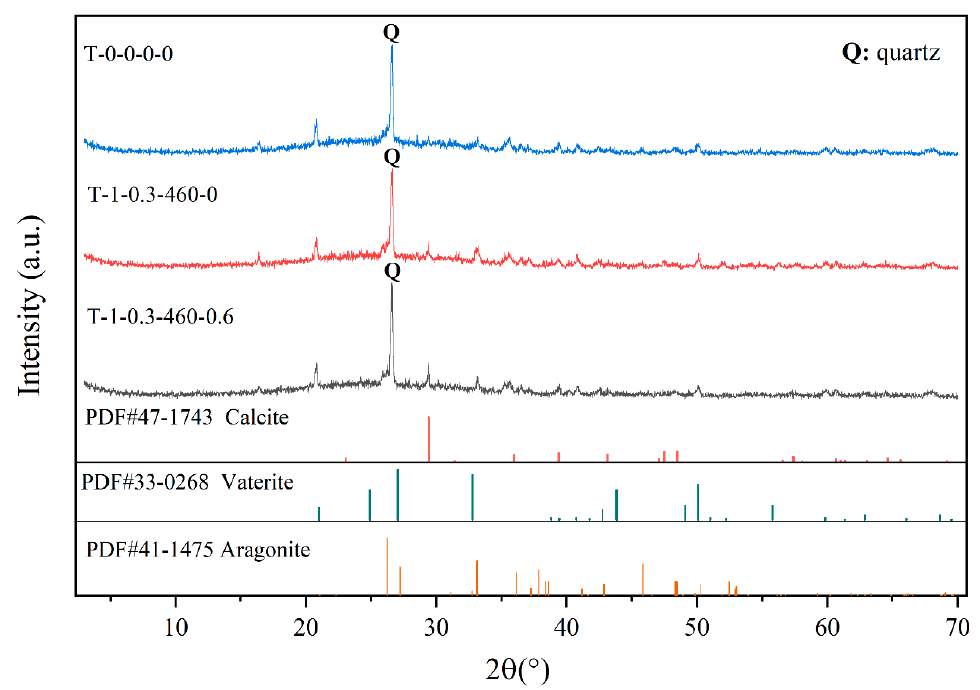
Figure 6. XRD patterns of the “crust” for samples cured by different methods. The red lines, green lines, and tawny lines at the bottom of the Figure are the PDF references for calcite (#47-1743), vaterite (#33-0268), and aragonite (#41-1475), respectively.